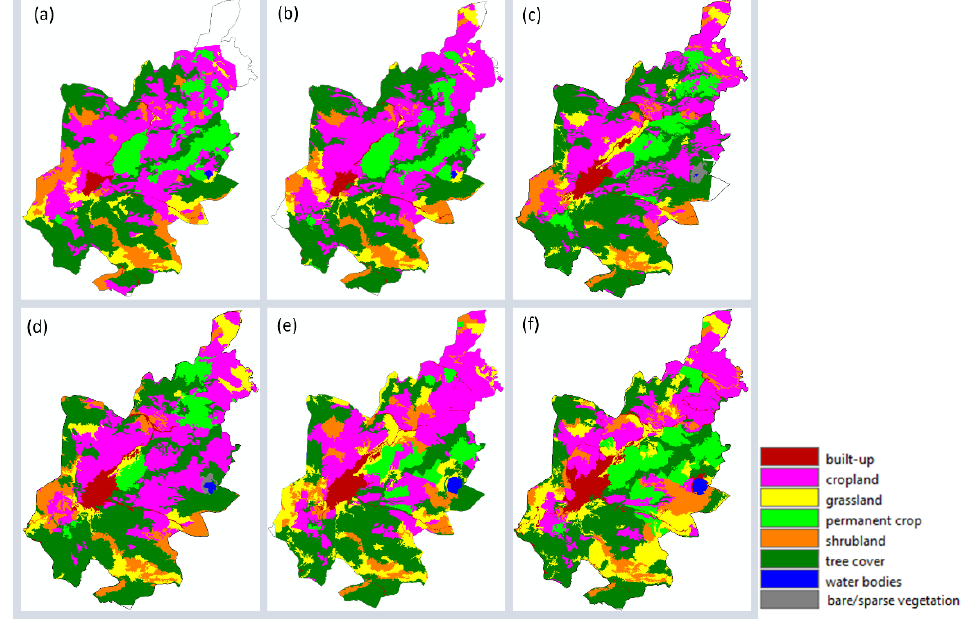
Figure 17. Land cover maps of Ruen in: ( a ) 1945, ( b ) 1952, ( c ) 1965, ( d ) 1968, ( e ) 1975, ( f ) 1980. Table 9. Temporal evolution of the LULC classes in Ruen from 1945 to 1980 (in absolute numbers and percentages).